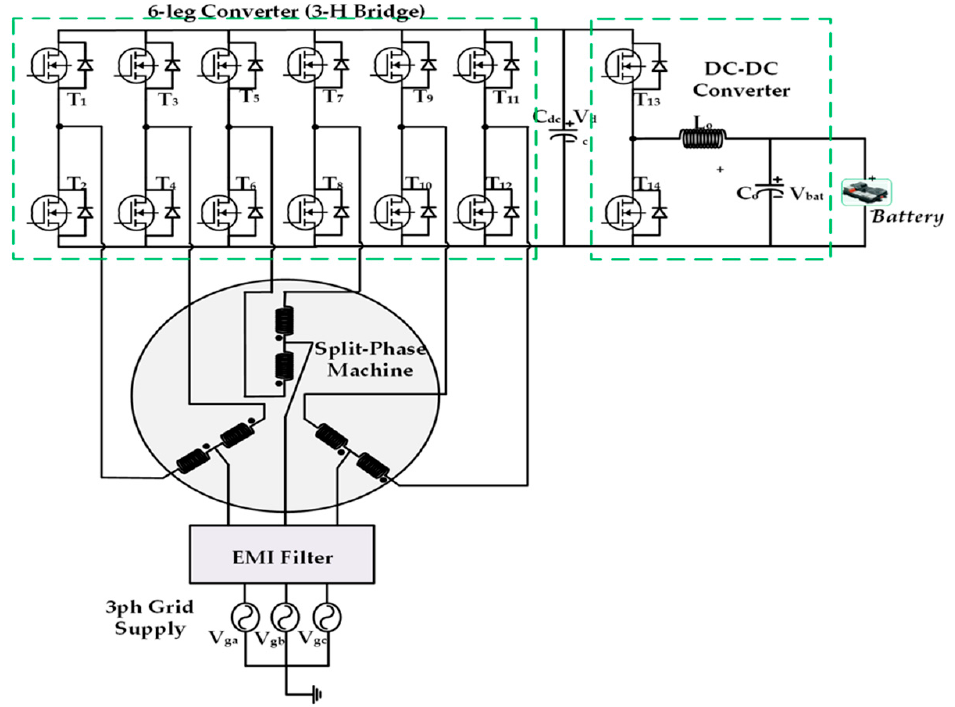
Figure 12. Three Phase Split-Phase Motor integrated on − board charger proposed by Hagbin et al [74] in 2014 (iOBC8).